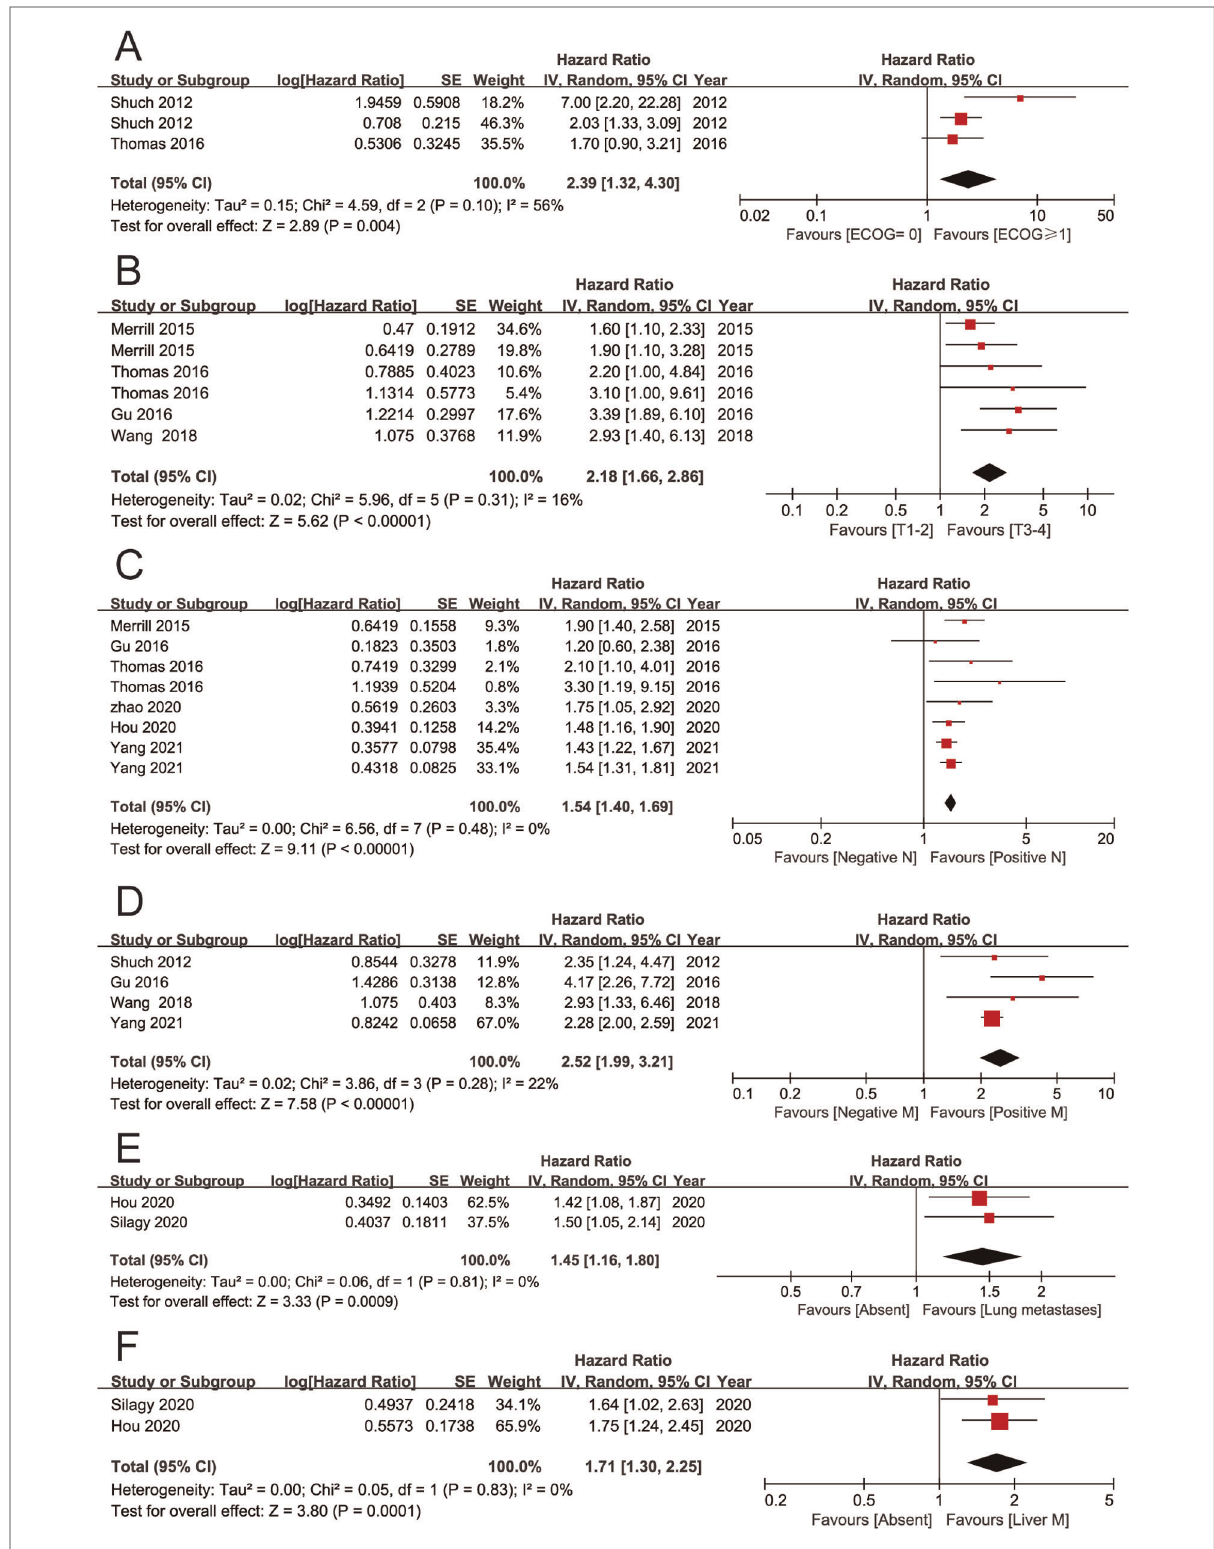
FIGURE 2 Forrest plots of meta-analyses of predictors of overall survival: ( A ) ECOG PS ( ≥ 1 vs 0); ( B ) T stage (3 – 4 vs 1 – 2); ( C ) positive lymph node; ( D ) distant metastasis; ( E ) lung metastases; ( F ) liver metastases. ECOG PS, European Cooperative Oncology Group performance